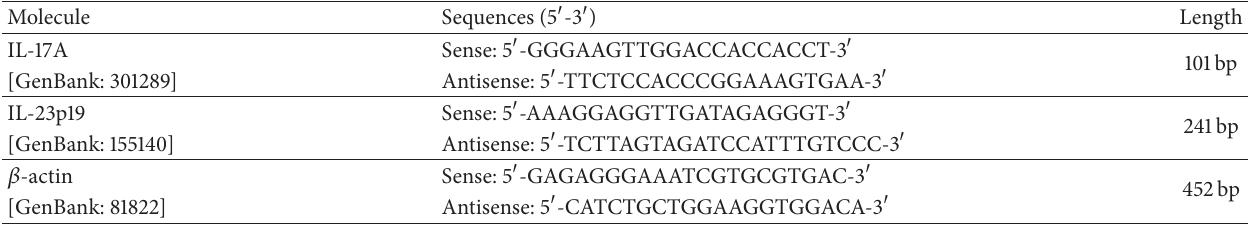
Table 1: Sequences of primers for PCR.